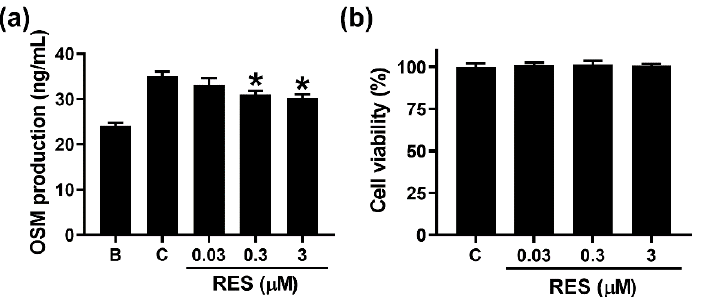
Figure 2. Effects of RES on the production of OSM in neutrophil-like dHL-60 cells. ( a ) dHL-60 cells (5 × 10 5 ) were exposed to RES (0.03 to 3 µM) for 1 h, and then stimulated with GM-CSF (5 ng/mL) for 4 h. ( b ) Cytotoxicity was examined using an MTT assay. B, PBS-added and unstimulated cells; C, PBS-added and GM-CSF-stimulated cells. Data are shown as the mean ± SEM of three independent experiments. * p < 0.05 vs. the PBS-added, and GM-CSF-stimulated cells. 3.2. RES Reducs OSM mRNA Expression in Neutrophil-like dHL-60